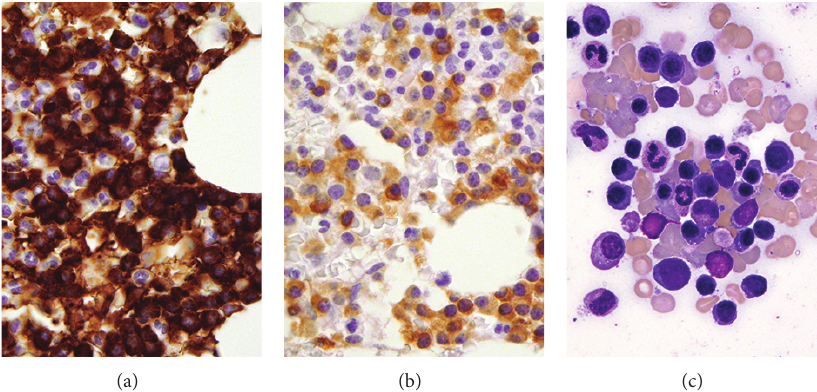
Figure 1: Case1. (a) Biopsy from initial sample demonstrating that the majority of cells express IgM. (b) A subset of cells express IgD, (c) Aspirate smear of second pretreatment marrow evaluation. Immunohistochemistry, oil objective, original magnification × 500 ((a) and (b)); Wright-Giemsa, oil objective, original magnification × 1000